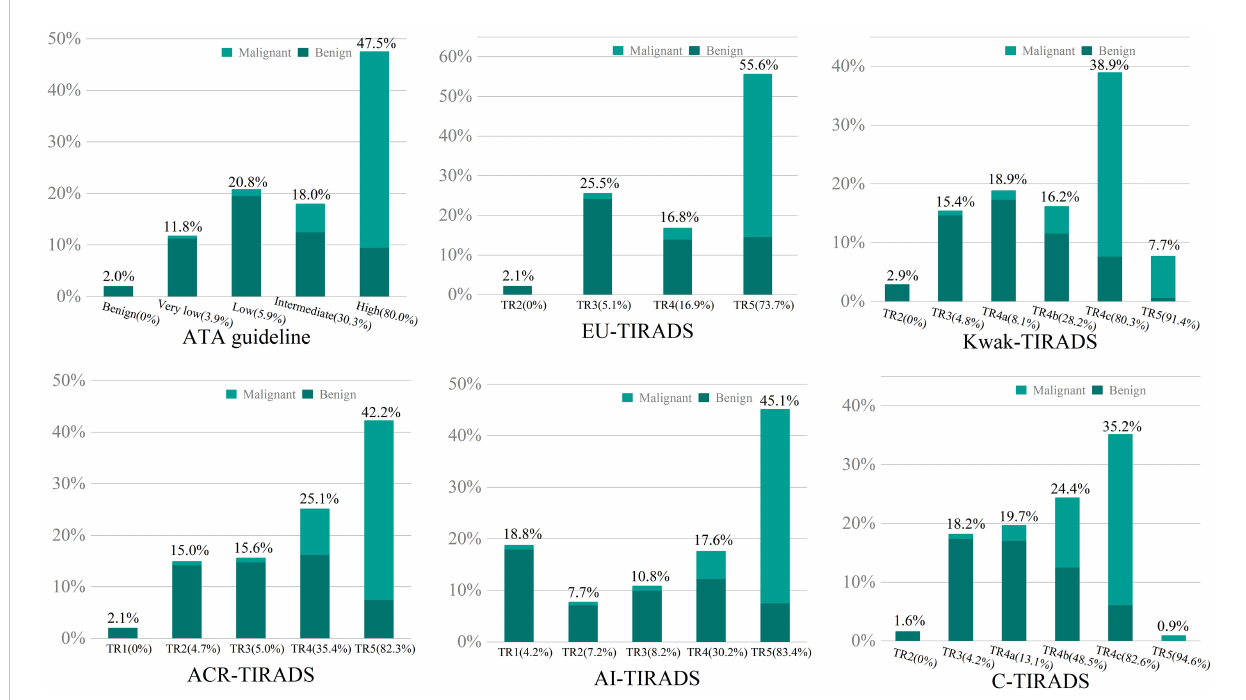
FIGURE 1 The calculated malignancy rates and proportion of nodule numbers at each category in the six RSSs were plotted on the bar graph with the abscissa as categories and the ordinate as proportion of number. Numbers in brackets depict the calculated malignancy rates in each